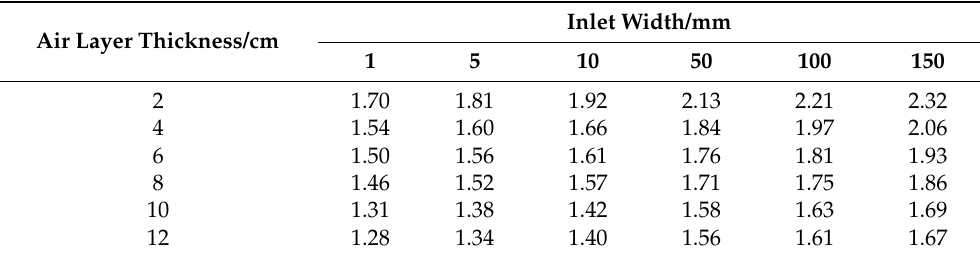
Table 8. Heat transfer coefficient value (unit: W · m − 2 · K − 1